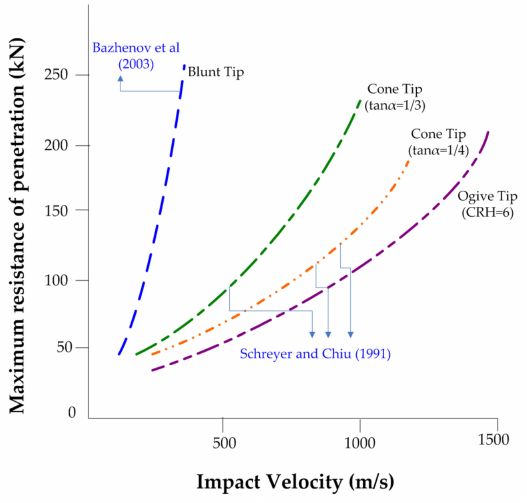
Figure 9. Maximum penetration resistance force on projectiles using laboratory model